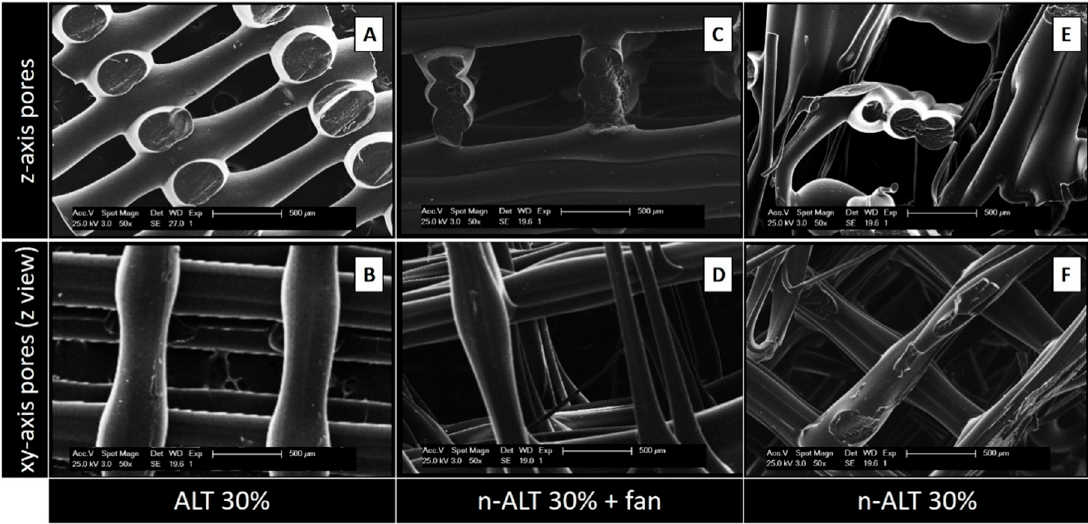
Figure 3. SEM images from the alternated ( A – B ) and non-alternated ( C – F ) scaffolds, obtained from lateral sections of cut samples ( A , C and E ) or from the top ( B , D and F ). E and F represent more chaotic structures due to the slow rate of cooling down, as no external fan was used. Scale bars: 500 µm.